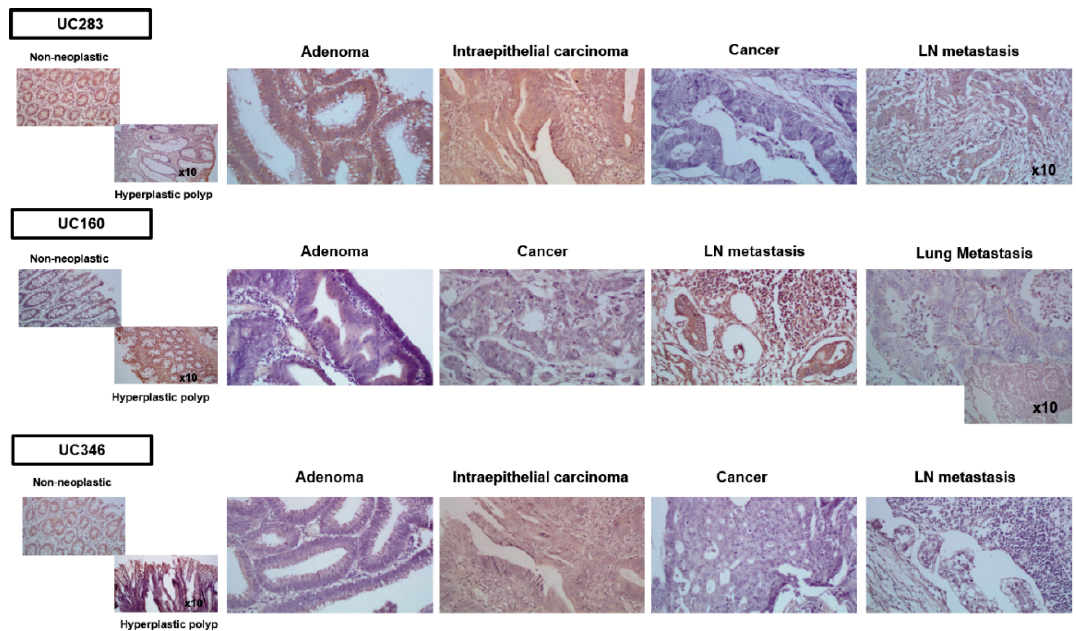
Figure 4. Microphotographs showing Uc160, Uc283, and Uc346 expression in non-neoplastic tissues, hyperplastic polyps, cancerous tissues, and metastatic lesions. LN: lymph node.